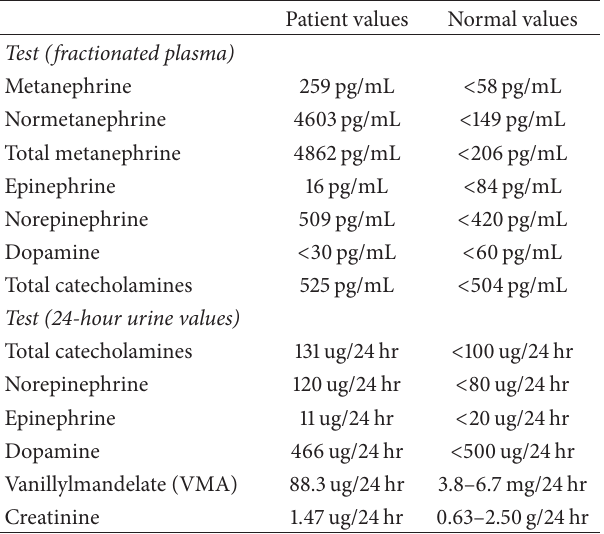
Table 1: Biochemical investigations confirming the pheochromocy- toma